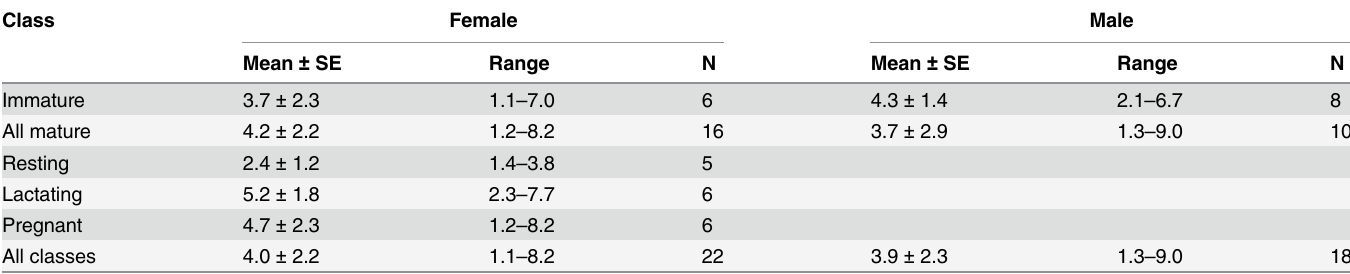
Table 2. Mean cortisol concentrations in the blubber of immature and mature male and female Delphinus delphis (bycatch specimens) of various reproductive states.